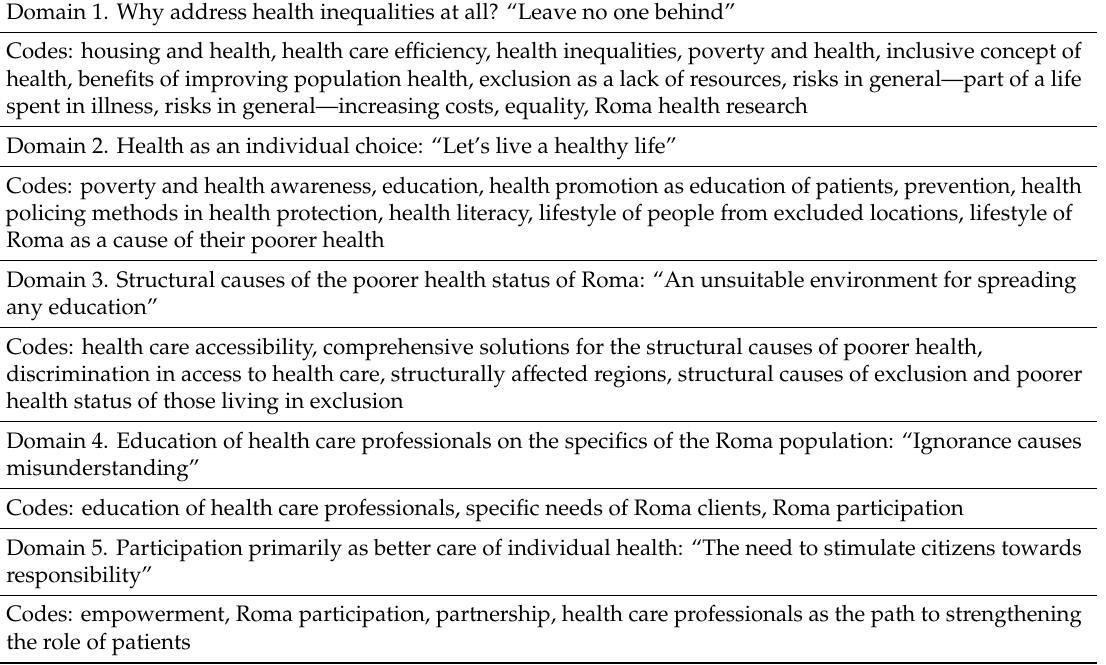
Table 2. Categories and codes characteristic for the way Roma are presented in relation to their health in the analyzed